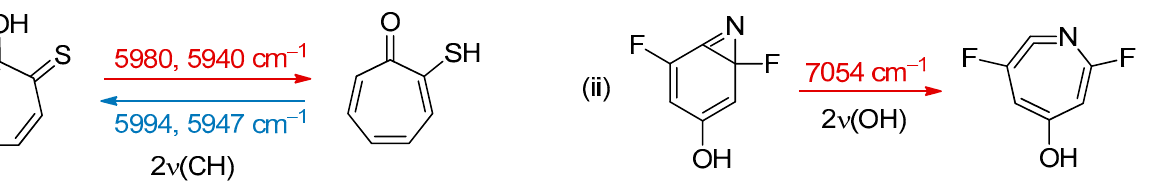
Figure 1. Proof-of-principle examples of molecular reactions induced under matrix isolation conditions by selective vibrational excitation with near-IR light at the frequency of stretching overtones (2ν(CH) and 2ν(OH)).